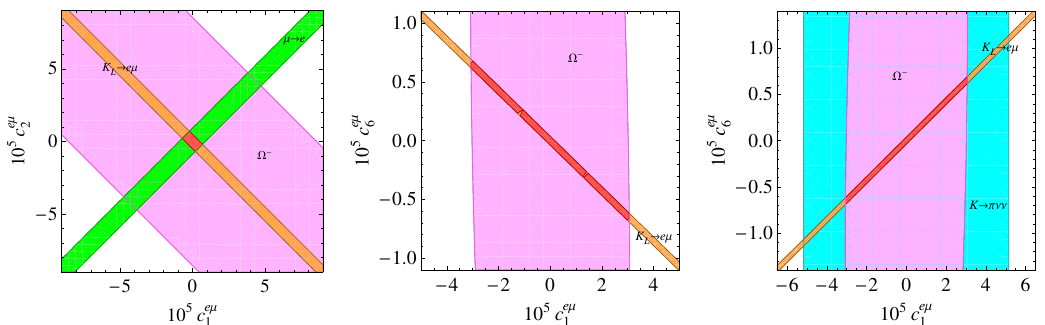
Figure 4 . Comparative constraints on selected LFV couplings in eq. (1.4), for Λ np = 1 TeV, from current 90%-CL upper bounds on NP effects in K in gold and a possible future bound of that the couplings are real and c eµ in the